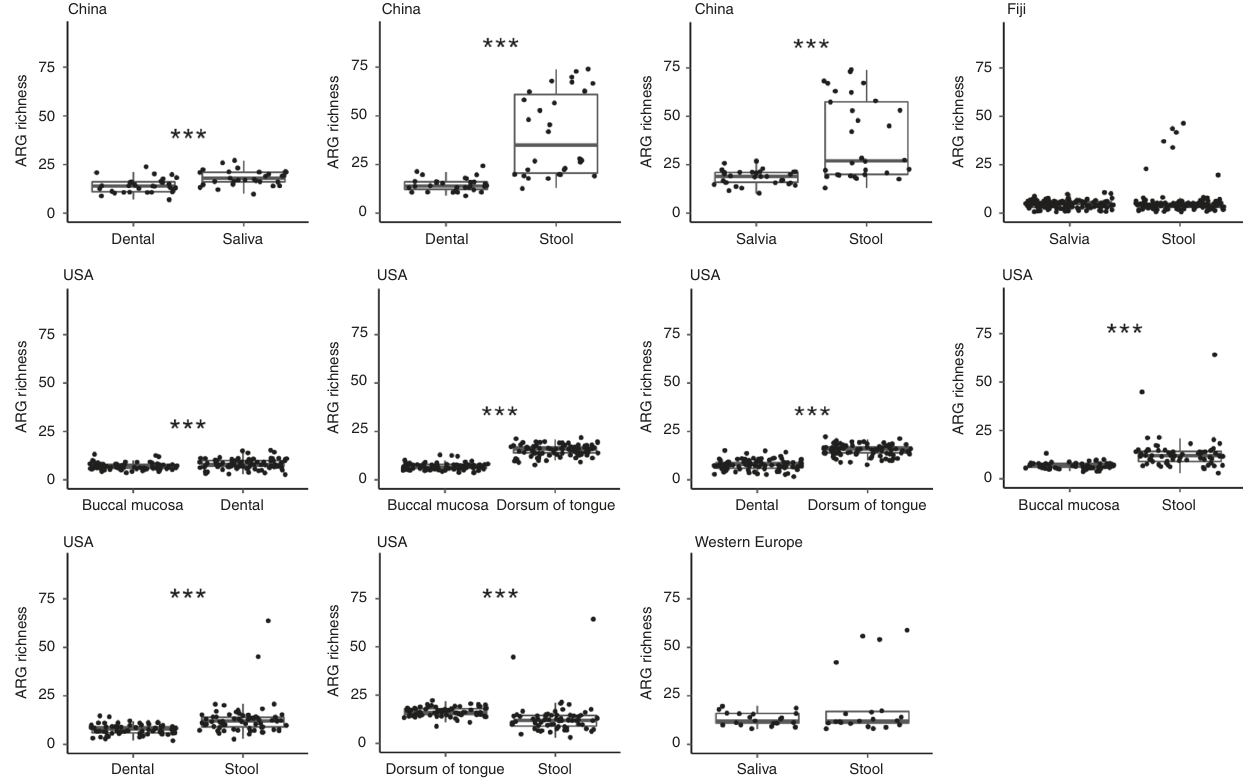
Fig. 4 Comparing ARG richness between paired body sites. ARG richness is de fi ned as the number of unique ARGs for paired samples of individual from China (dental plaque and saliva: n = 31, stool and dental plaque: n = 30, stool and saliva: n = 31), Fiji (saliva and stool: n = 132), the USA (buccal mucosa and dental plaque: n = 78, buccal mucosa and dorsum of tongue: n = 86, dental plaque and dorsum of tongue: n = 89, stool and buccal mucosa: n = 64, stool and dental plaque: n = 68, stool and dorsum of tongue: n = 69) and Western Europe (saliva and stool: n = 21) with Mann – Whitney, paired, two-sided t test ( p -value < 0.05 as *< 0.01 as **< 0.005 as ***). Centre line is median, box limits are upper and lower quartiles, whiskers are 1.5× interquartile ranges and points beyond whiskers are outliers. Source data are provided in the Source Data fi le.